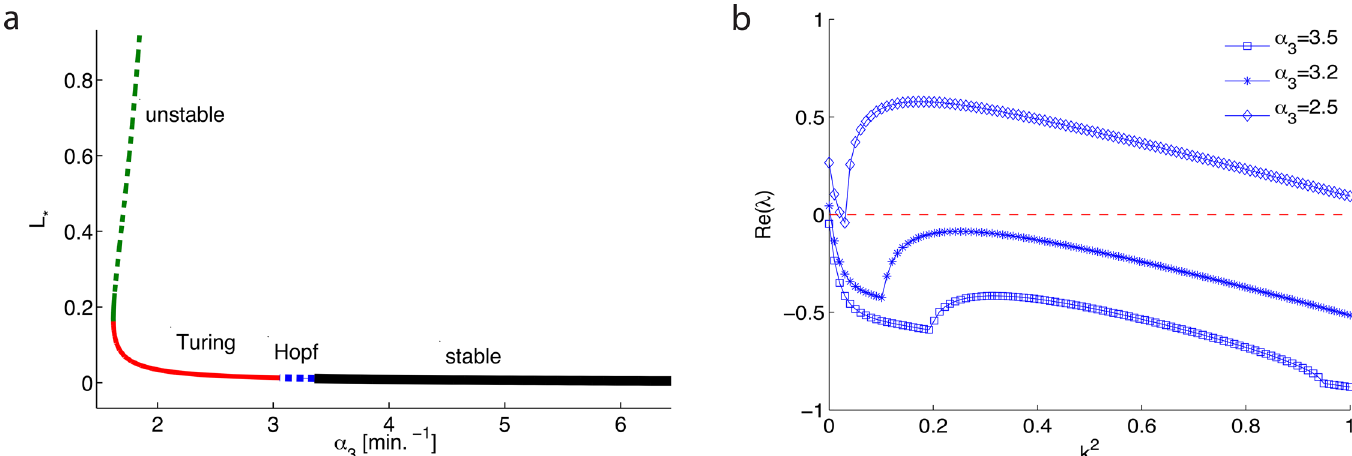
Fig 2. Slowing AiiA production in Eqs (1) – (4) leads to oscillations and Turing patterns. (a) A codimension one bifurcation of the AHL fixed point, L * , losing stability through a Hopf bifurcation and into a Turing instability as Aiia production rate is decreased. (b) Eigenvalue-wavenumber curves at various AiiA maximal production rates, corroborating the bifurcation analysis results. At the cusp of each curve the eigenvalues become a complex conjugate pair, with each low eigenvalue left off the plot for clarity.